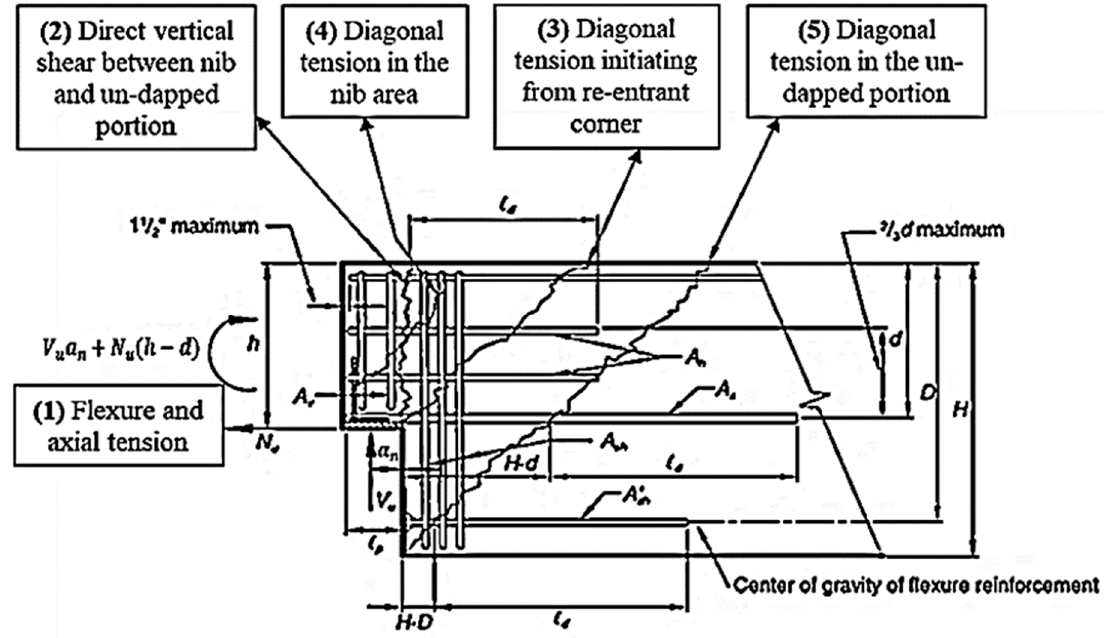
Figure 1. Modes of failure of DEBs as prescribed in PCI code (PCI code,